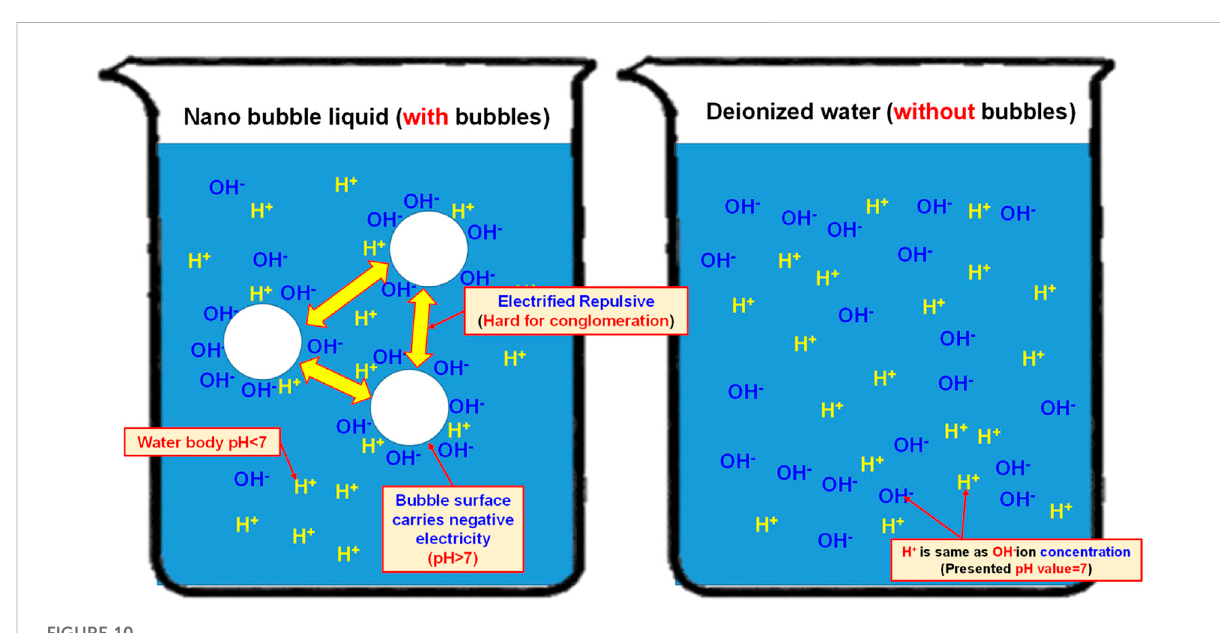
FIGURE 10 Effect of nanobubbles on H + and OH − ions in the